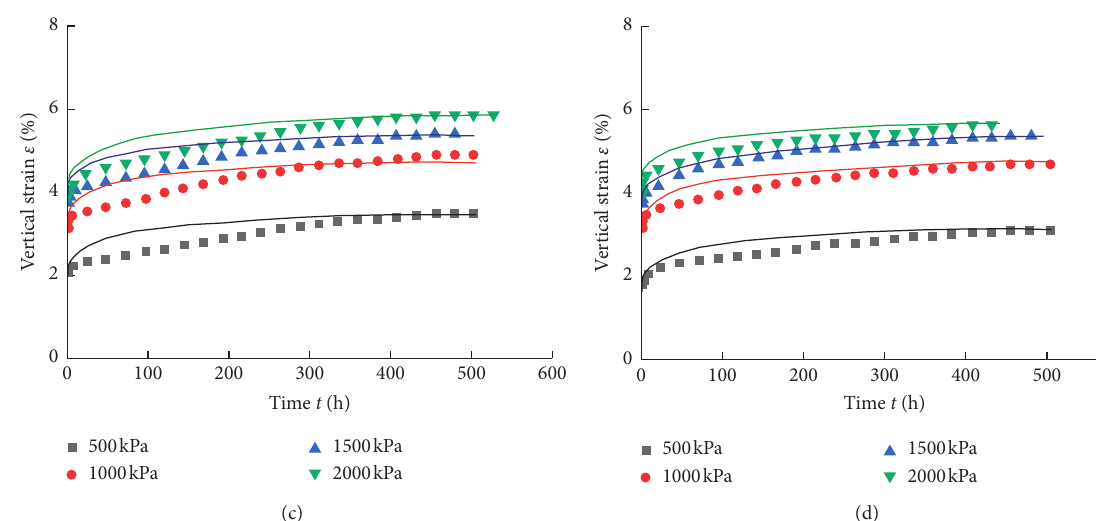
Figure 11: Comparison of calculation results and test results. (a) E